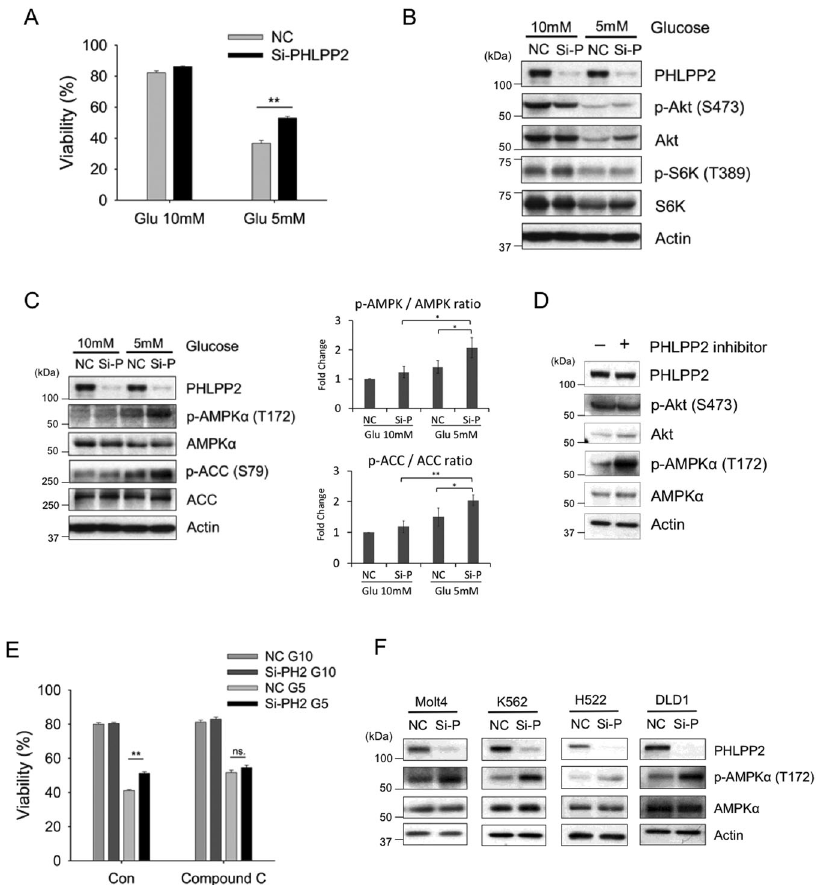
Fig. 1 PHLPP2 suppresses cell survival under metabolic stress by targeting AMPK. A Jurkat cells were transfected with control siRNA (NC) or PHLPP2 siRNA (Si-PHLPP2) and, 24 h later, cultured for 4 days in 10 mM (high) or 5 mM (low) glucose medium. Cell viability was measured by fl ow cytometric analysis of Annexin V/PI uptake. Western blots of lysates from control siRNA (NC) or PHLPP2 siRNA (Si-P) transfected Jurkat cells, 3 days after growth in medium with 10 mM or 5 mM glucose showing phospho-Akt (S473), total Akt, phospho-S6K (T389), and total S6K protein expression ( B ), phosphorylation of AMPK α (T172) and downstream target, ACC ( C, left), and averaged pAMPK α /AMPK and pACC/ACC ratios scanned from three independent experiments ( C , right). D PHLPP2 inhibitor increases phosphorylation of AMPK α . Western blot showing phospho-AMPK α and total AMPK α in lysates of Jurkat cells grown in the presence of a PHLPP2 inhibitor (20 μ M) for 72 h. E AMPK inhibitor, Compound C, abrogates the pro-survival effect of PHLPP2 loss under metabolic stress. Control siRNA (NC) or PHLPP2 siRNA